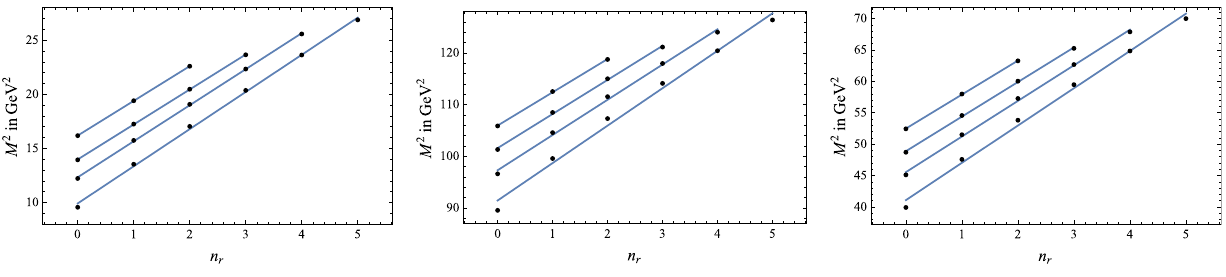
Fig. 3 Parent and daughter Regge trajectories ( n r → M 2 ) for charmonia (left), bottomonia (middle) and B c (right)